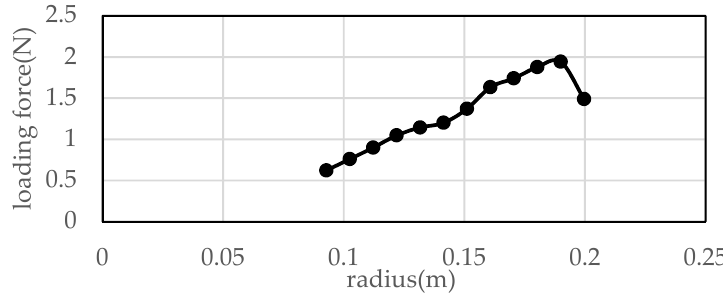
Figure 4. Blade surface loading force distribution along the blade radius.